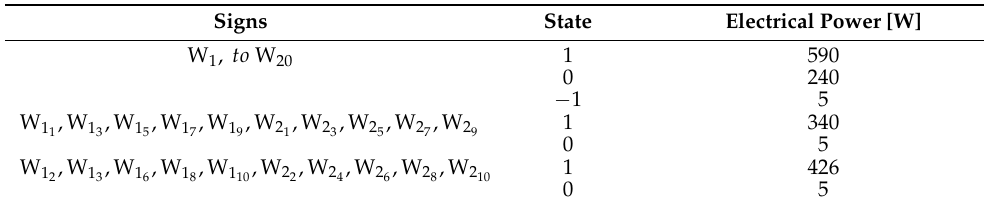
Table 4. Measured electrical power of system components.